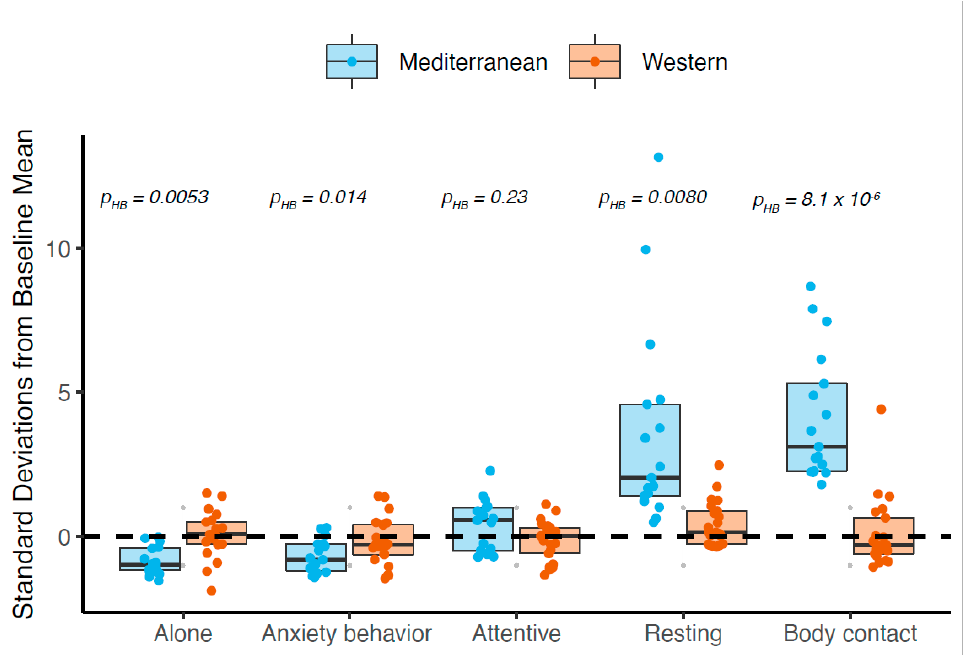
Figure 3. Diet-driven changes in behavior are due to changes in Mediterranean-fed animals from baseline. Western-fed animals do not show a significant difference between the baseline (time 0) and treatment phases (average of months 1–24) in any of the five behaviors that are affected by diet (all Holm–Bonferroni-adjusted p > 0.05). Mediterranean-fed animals show significant differences between the baseline and treatment phase in all diet-altered behaviors except the percent of attentive time. Reported Holm–Bonferroni-adjusted p ( p HB ) are for ANOVA of the Mediterranean group animals compared to their own baseline measurements. Blue (Mediterranean) and orange (Western) points indicate treatment phase values standardized against the across-group baseline mean (when all animals consumed a chow diet).